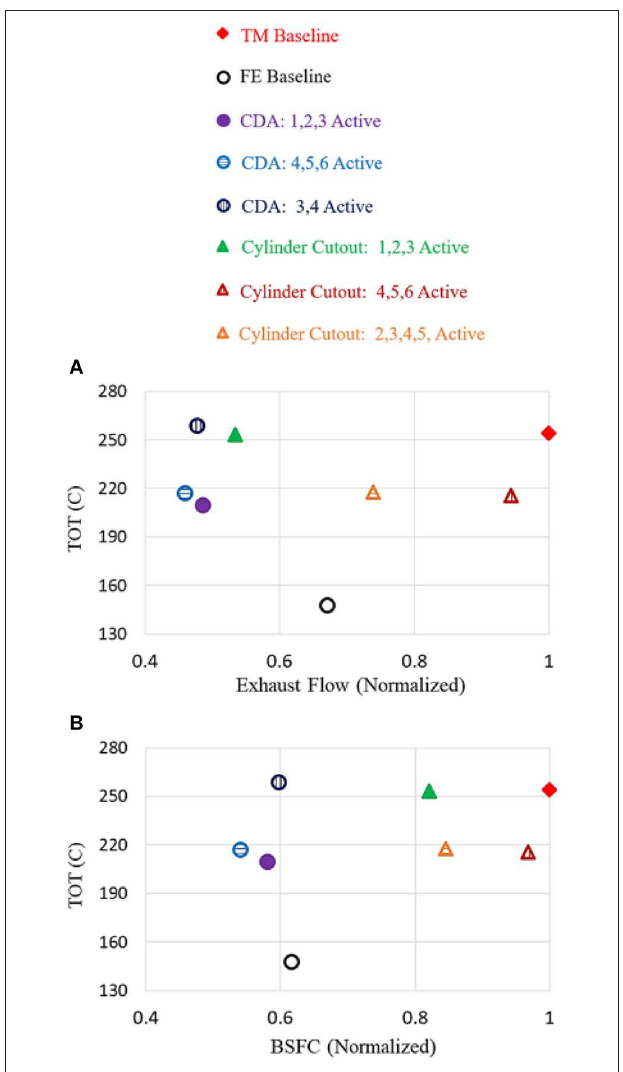
FIGURE 10 | (A) Represents TOT and exhaust flow for each strategy. (B) Represents TOT and BSFC for each strategy. Elevated TOT and exhaust flows are ideal for warm-up; whereas low exhaust flows and BSFC are key for